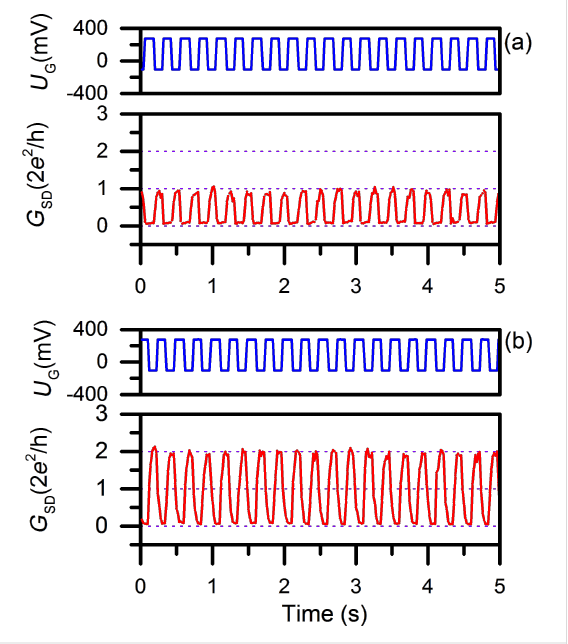
Figure 6: Demonstration of bistable quantum conductance switching of the copper atomic-scale transistor driven with a function generator. The bistable quantum conductance switching (red) between 0–1 G 0 (a) and 0–2 G 0 (b) follow the controlling rectangular wave (blue) at 4 Hz between − 105 mV (off) and 275 mV (on) given by the function gener-